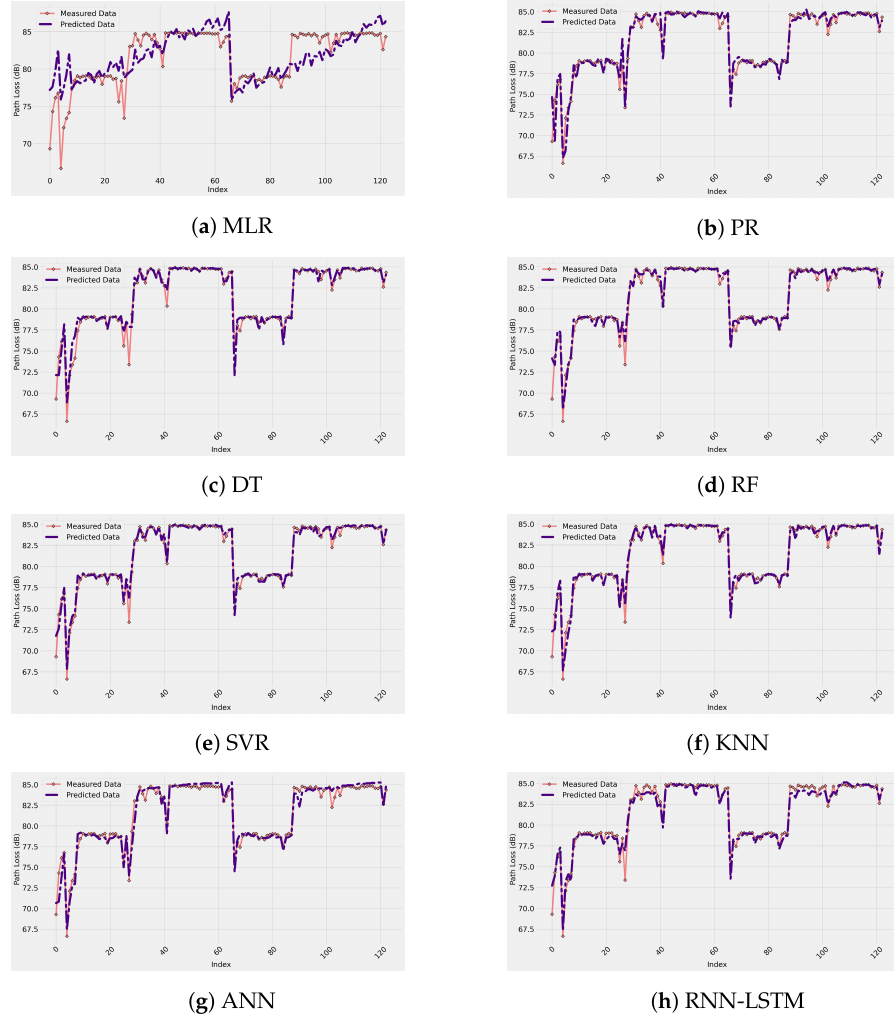
Figure 6. Measured and predicted path loss data for each ML-based